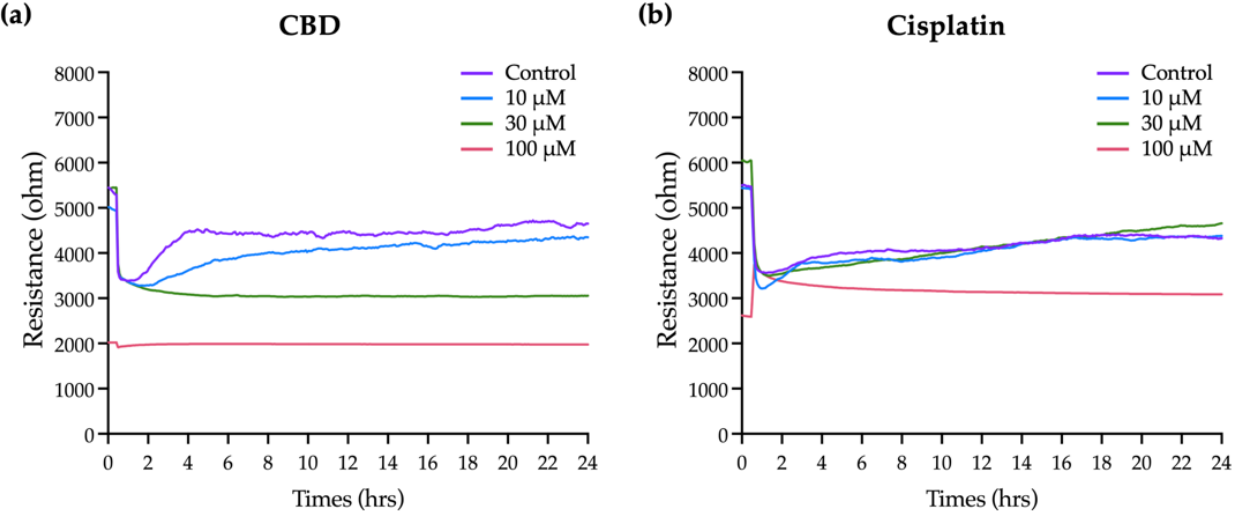
Figure 5. Effect of CBD and cisplatin on the migration of OEC-M1 cells. The wound area of the cell layer on the electrode is created by passing a relatively high current (at time 0, indicated by the black arrow). Subsequent resistance recovery gradients show the migration of OEC-M1 cells after exposure to ( a ) CBD and ( b ) cisplatin at 10, 30, and 100 µ M. Each curve contains similar results for at least three independent experiments.